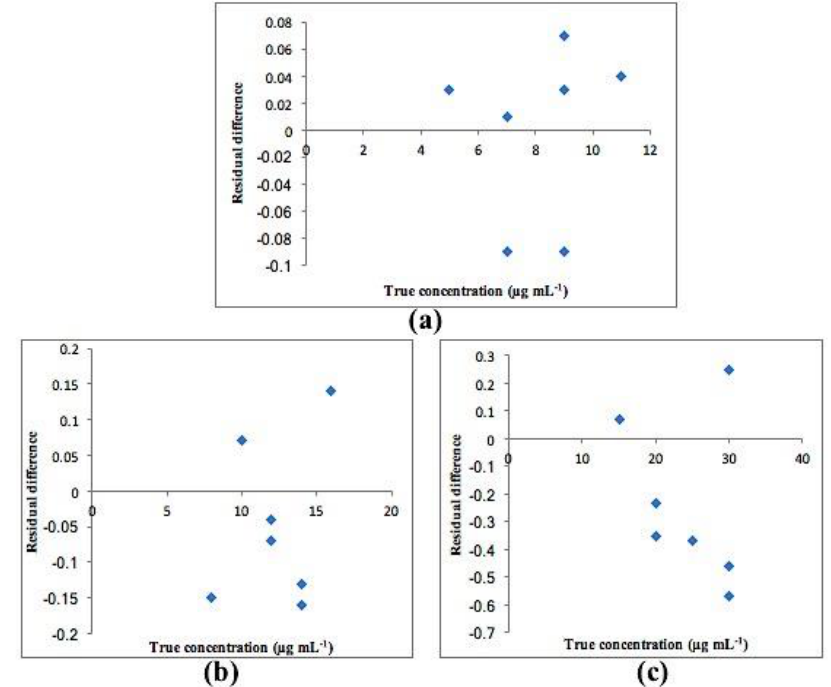
Figure 7. Residual plot of residual difference between true and found concentrations for ( a ) CS, ( b ) Deg1 and ( c ) Deg2 for PCR model.